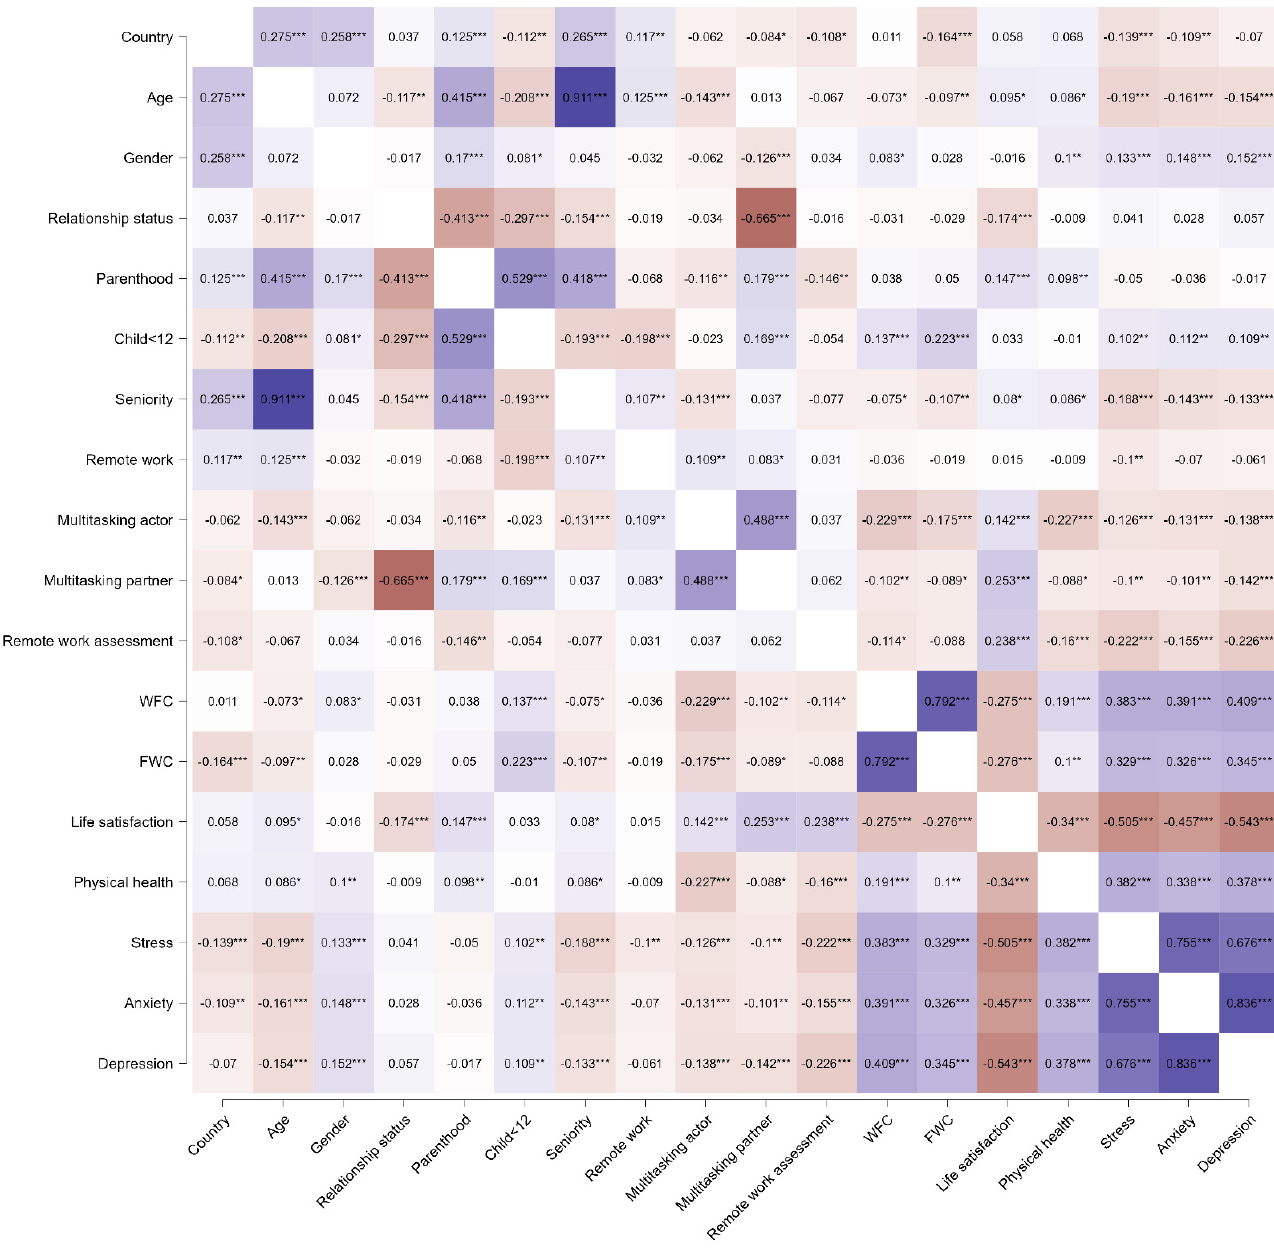
Figure 2. The relationships between the demographic, family-specific and work-specific variables, and well-being dimensions. Positive correlations are marked in violet while negative correlations are marked in red. * p < 0.05, ** p < 0.01, *** p < 0.001. The multiple linear regression was performed for WFC and FWC as dependent vari- Table 2. Multiple linear regression for work-family conflict. ables and a set of demographics, family-related, work-related, and well-being variables as predictors. Significant predictors of WFC were: Polish country, low self-perceived